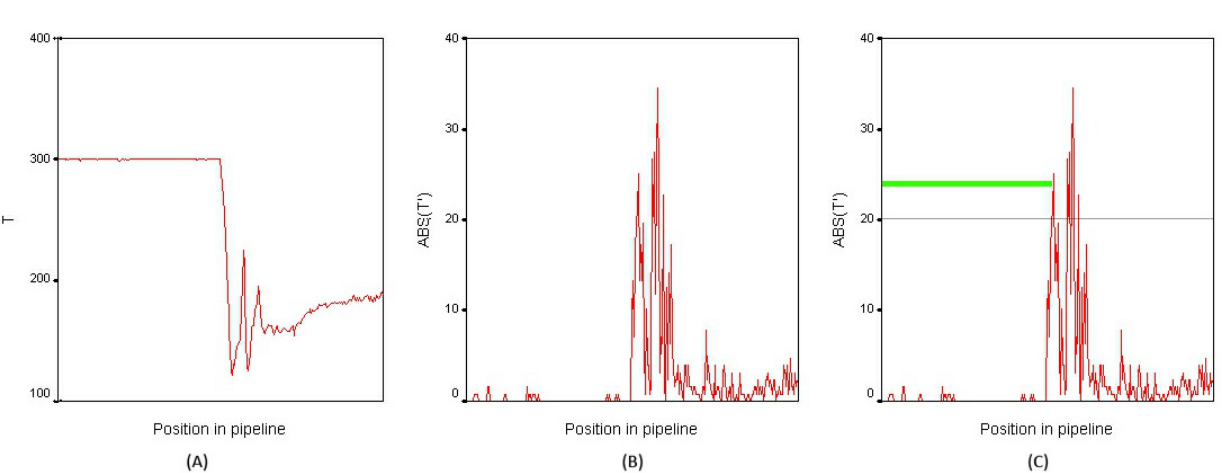
Figure 5. ( A ) Temperature along the pipeline; ( B ) Absolute value of the first derivative; and ( C ) Detection on the